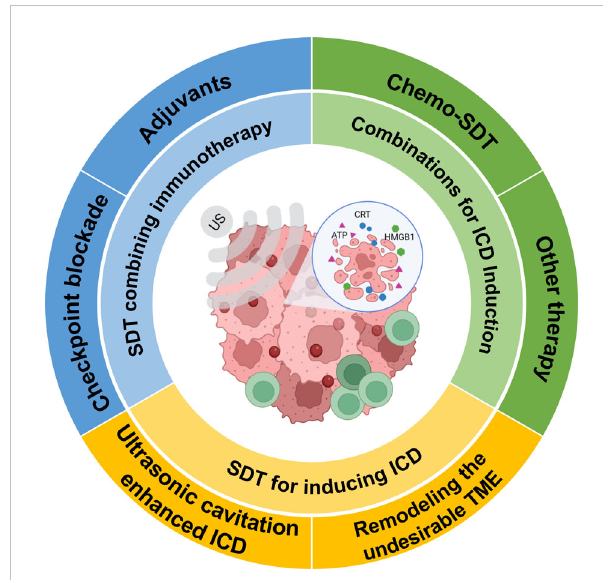
FIGURE 2 Schematic representation of SDT for inducing immunogenic cell death and potentiating cancer immunotherapy (Created with